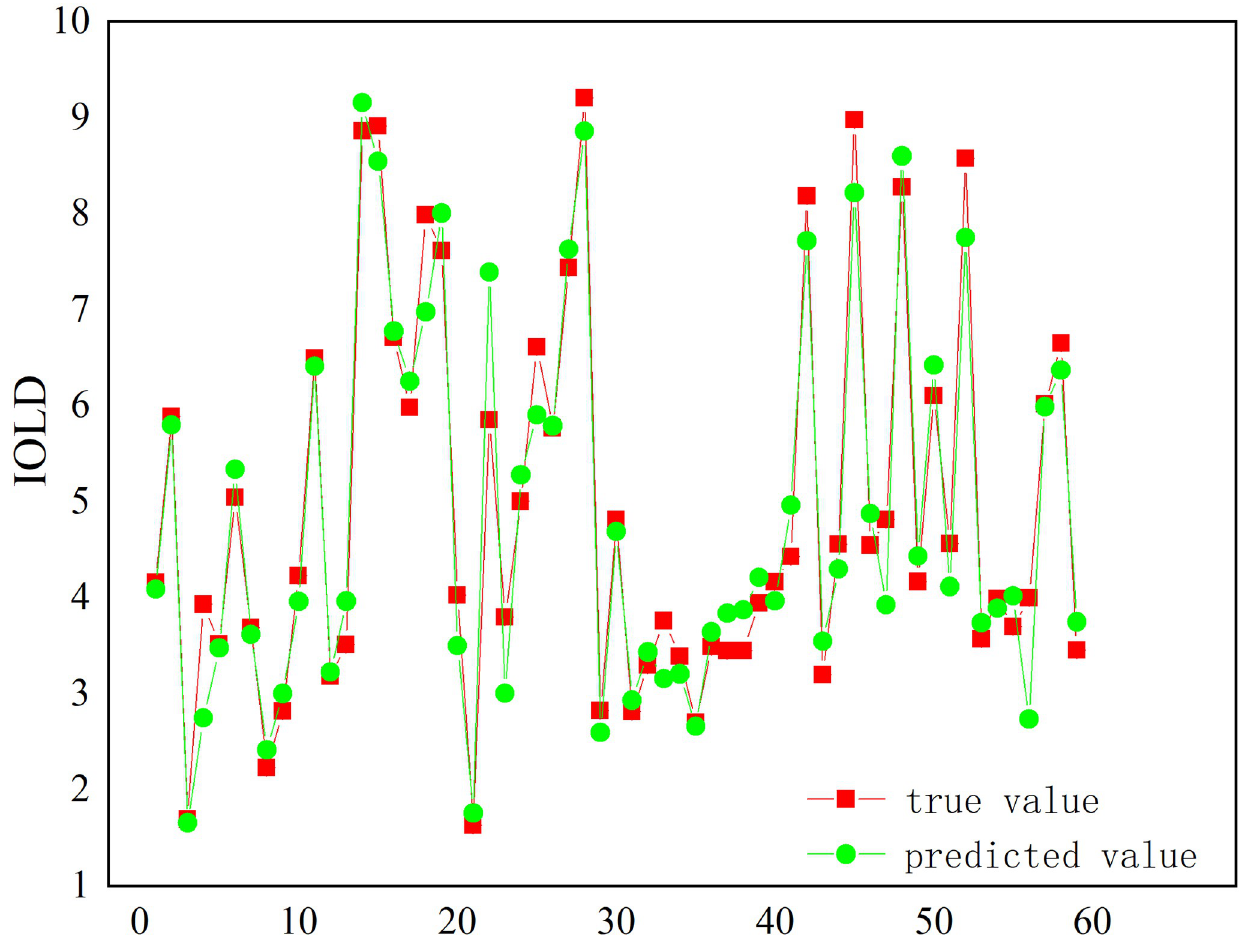
Fig 7. The fitting map of land development intensity test based on the XGBOOST